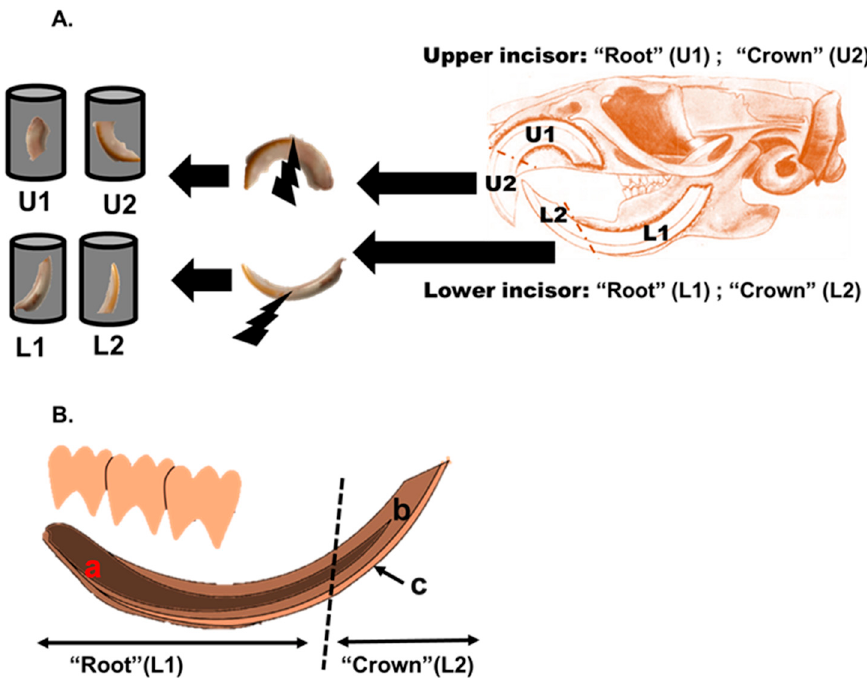
Figure 2. Divisions of the incisor teeth and schematic illustration of the longitudinal section of the incisor tooth. ( A ) Lower and upper incisor tooth divisions based on the yellow-orange enamel for microwave acid digestion. For upper incisors, the root (U1) part is anchored in the maxillary bone, and the crown (U2) part of the tooth is seen externally. Similarly, for lower incisors, the root (L1) part is anchored in the mandibular bone, and the crown (L2) part of the tooth is seen externally. ( B ) Illustrated schematic longitudinal section modified from Park et al. [31] of lower incisor tooth as was sectioned for direct LA-ICP-MS analysis. Furthermore, the three major parts of the incisor tooth are seen—(a) dental pulp, (b) dentine, and (c) enamel running only in the front part of the tooth. The dotted line is the imaginary division line used based on the obvious discoloration of enamel on the crown part of the tooth.